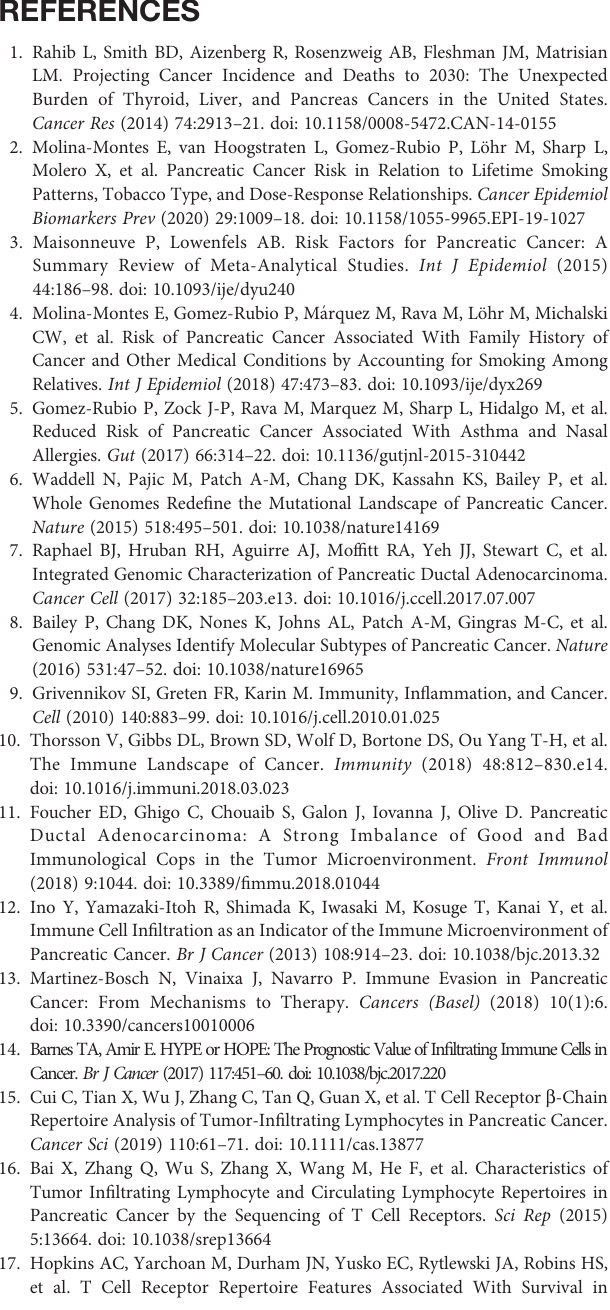
Supplementary Figure 2 | Entropy estimation after applying a downsampling strategy for IG entropy (A) and TCR (B) . The estimates were calculated randomly sampled different proportions (20, 40, 60, and 80) of the sequence data for each sample,andthemtheentropywascalculatedinitscorrespondingsampleddataset. The same processed was repeated 10 times in each proportion to avoid possible stochastic effects and calculated the mean value as the fi nal estimate. Supplementary Figure 3 | Gini(V) and Gini(C) after applying a downsampling strategy. The estimates were calculated randomly sampled different proportions (20, 40, 60, and 80) of the sequence data for each sample and the entropy was